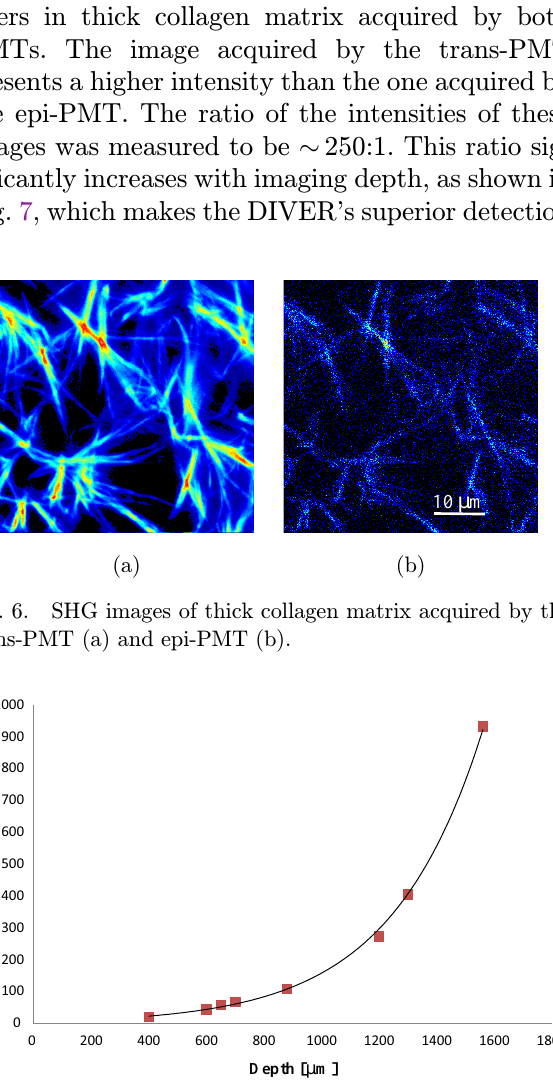
Fig. 7. Plot of ratio of SHG image intensities acquired by the trans-PMT and epi-PMT as a function of imaging depth.